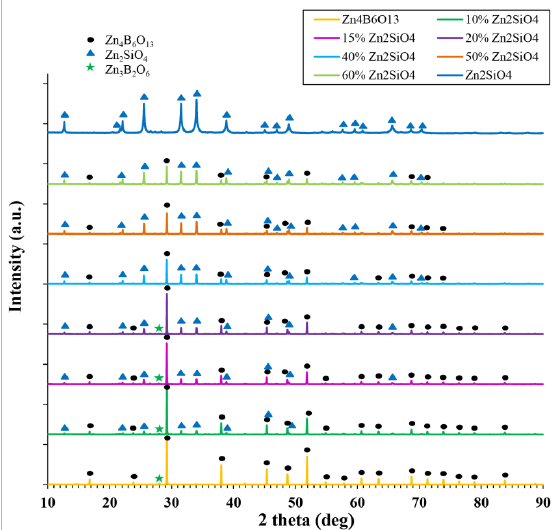
Figure 1. Diffraction patterns of Zn 4 B 6 O 13 –Zn 2 SiO 4 composites sintered at 930–950 °C.